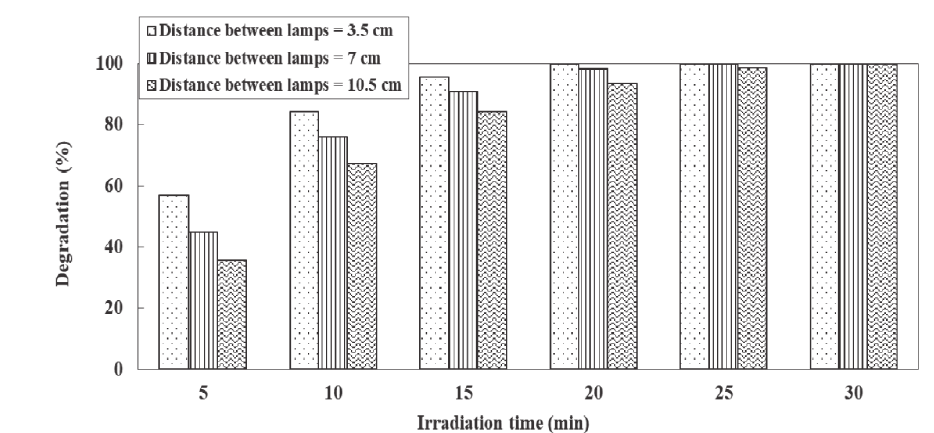
Fig. 8 – Effect of the lamps distance from each other on the removal percent of PNP in the SDP. [PNP] = 20 mg L –1 , volume = 500 mL, pH = 5.5, [H O ] = 1500 mg L –1 , rotation speed = 300 rpm, light intensity = 33 W m –2 . 2 2